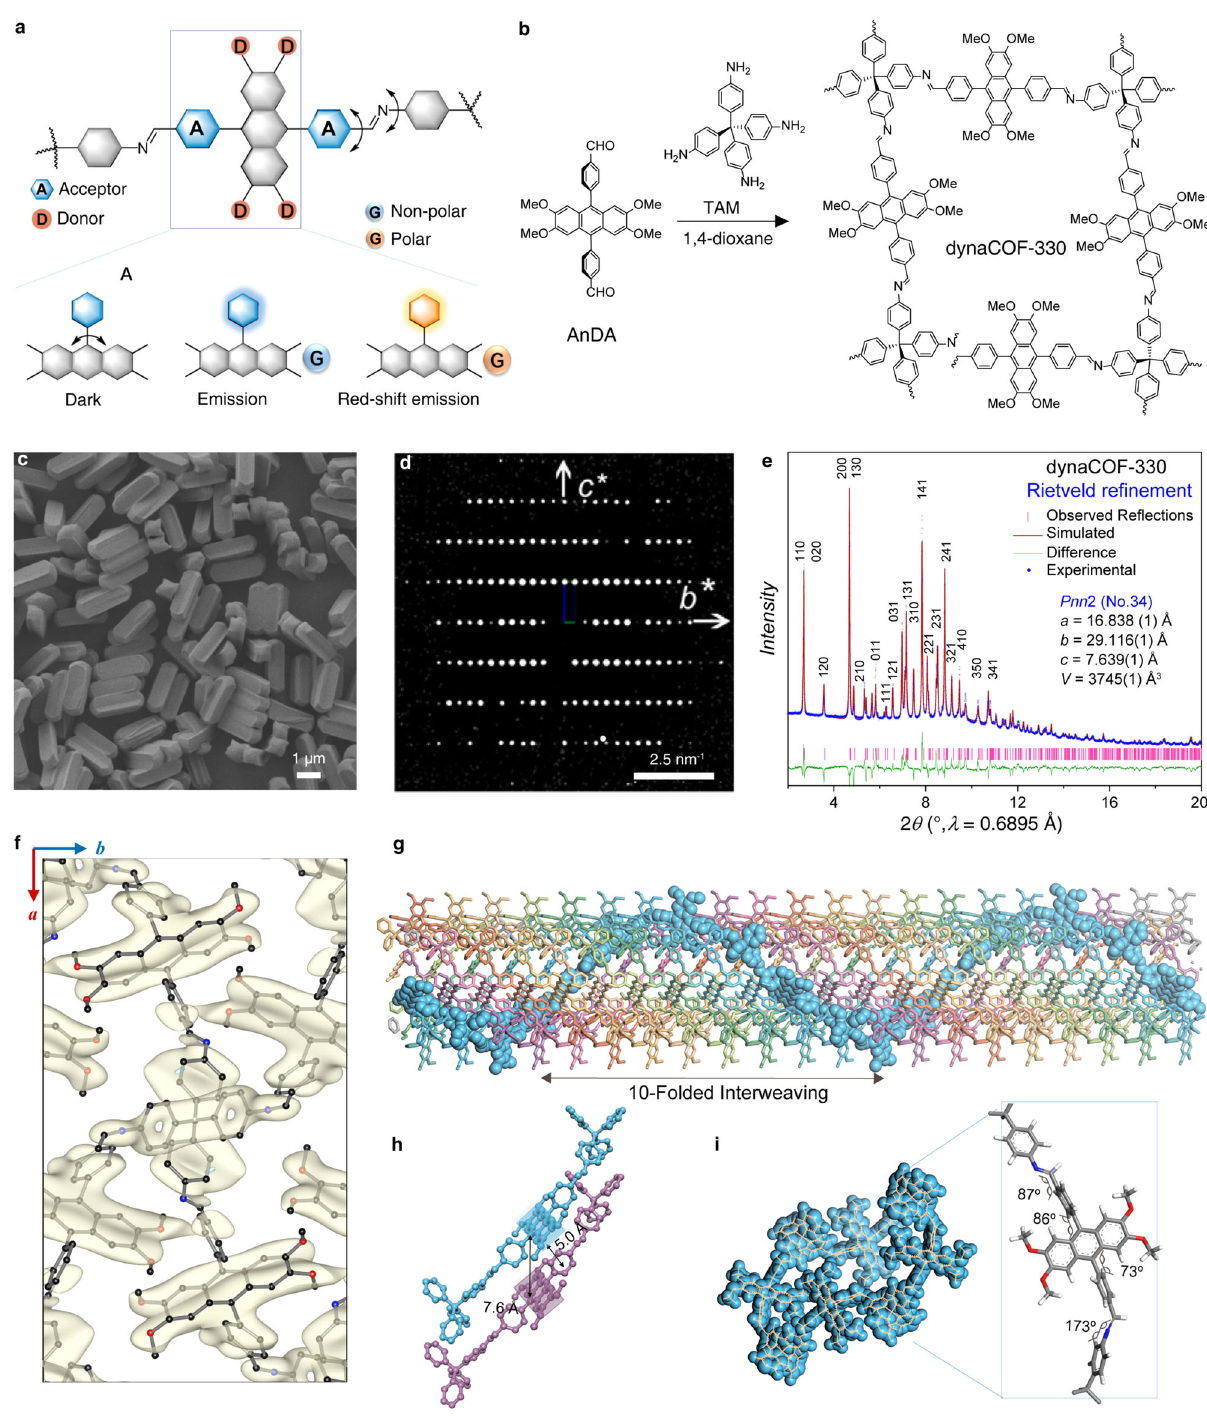
Fig. 2 | Design, preparation, and the crystal structure determination of dynaCOF-330. a Mechanism of fl uorescence turn-on by hindering the inter- molecular fl apping of fl uorophore and the fl uorescence colour tuned by chemical environments. b Solvothermal synthesis of the crystalline sample by imine con- densation of AnDA with TAM in 1,4-dioxane. c Morphology of the microcrystals showing well-de fi ned tetragonal prismatic shapes and uniform sizes. d Single- crystal 3D ED data reconstructed in reciprocal space projected along the [100] direction for determining lattice constants and space group symmetry. e Rietveld re fi nement of crystal structure obtained from the 3D ED data against the